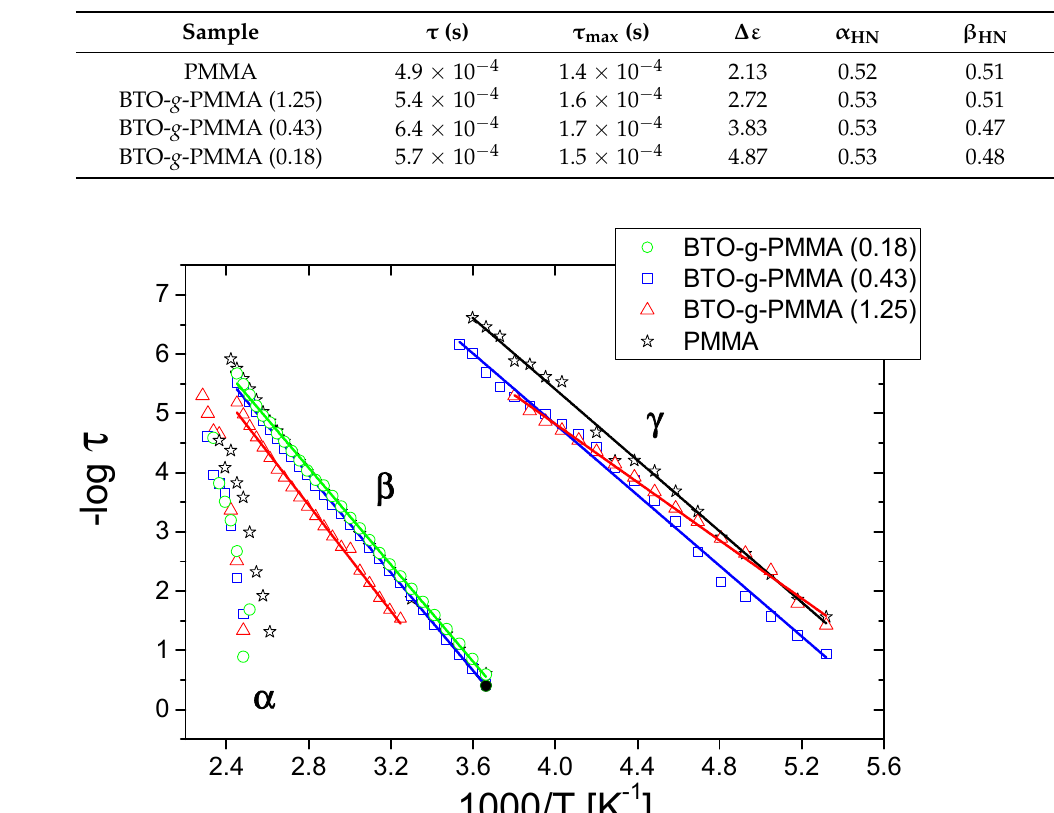
Table 2. Havriliak–Negami (HN) parameters for β -relaxation processes in studied BTO- g -PMMA composites obtained from analysis of dielectric spectra at 80 ◦ C. The data for neat PMMA was added for comparison.